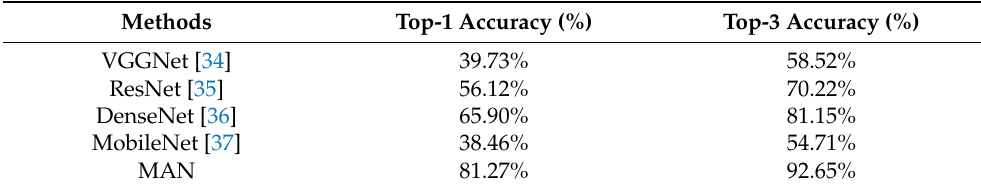
Table 2. Different models’ performances in the GPIAD dataset.